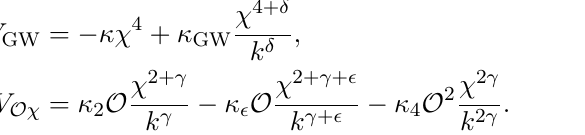
, there is a metastable minimum at χ = χ (inset, blue crit min (red and black curves), crit